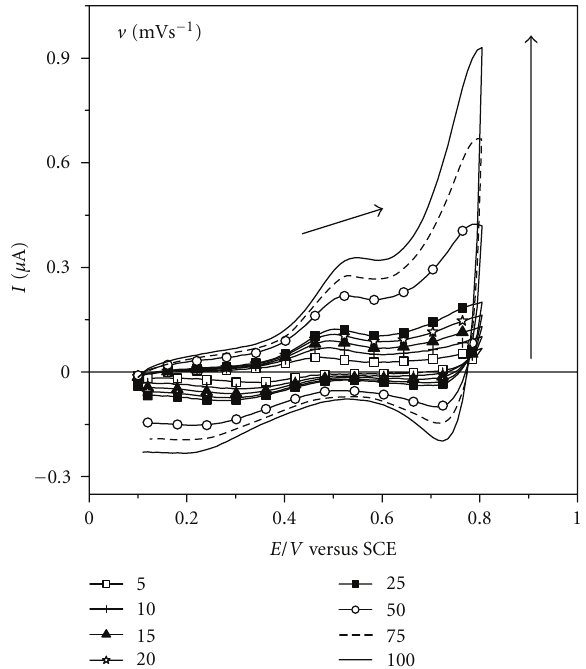
Figure 4: Study of the redox process of the film: cyclic voltammo- grams for ITO/(DS 01/NiTsPc) 3 film at di ff erent scanning speeds. Electrolyte solution H 2 SO 4 0.05mol L − 1